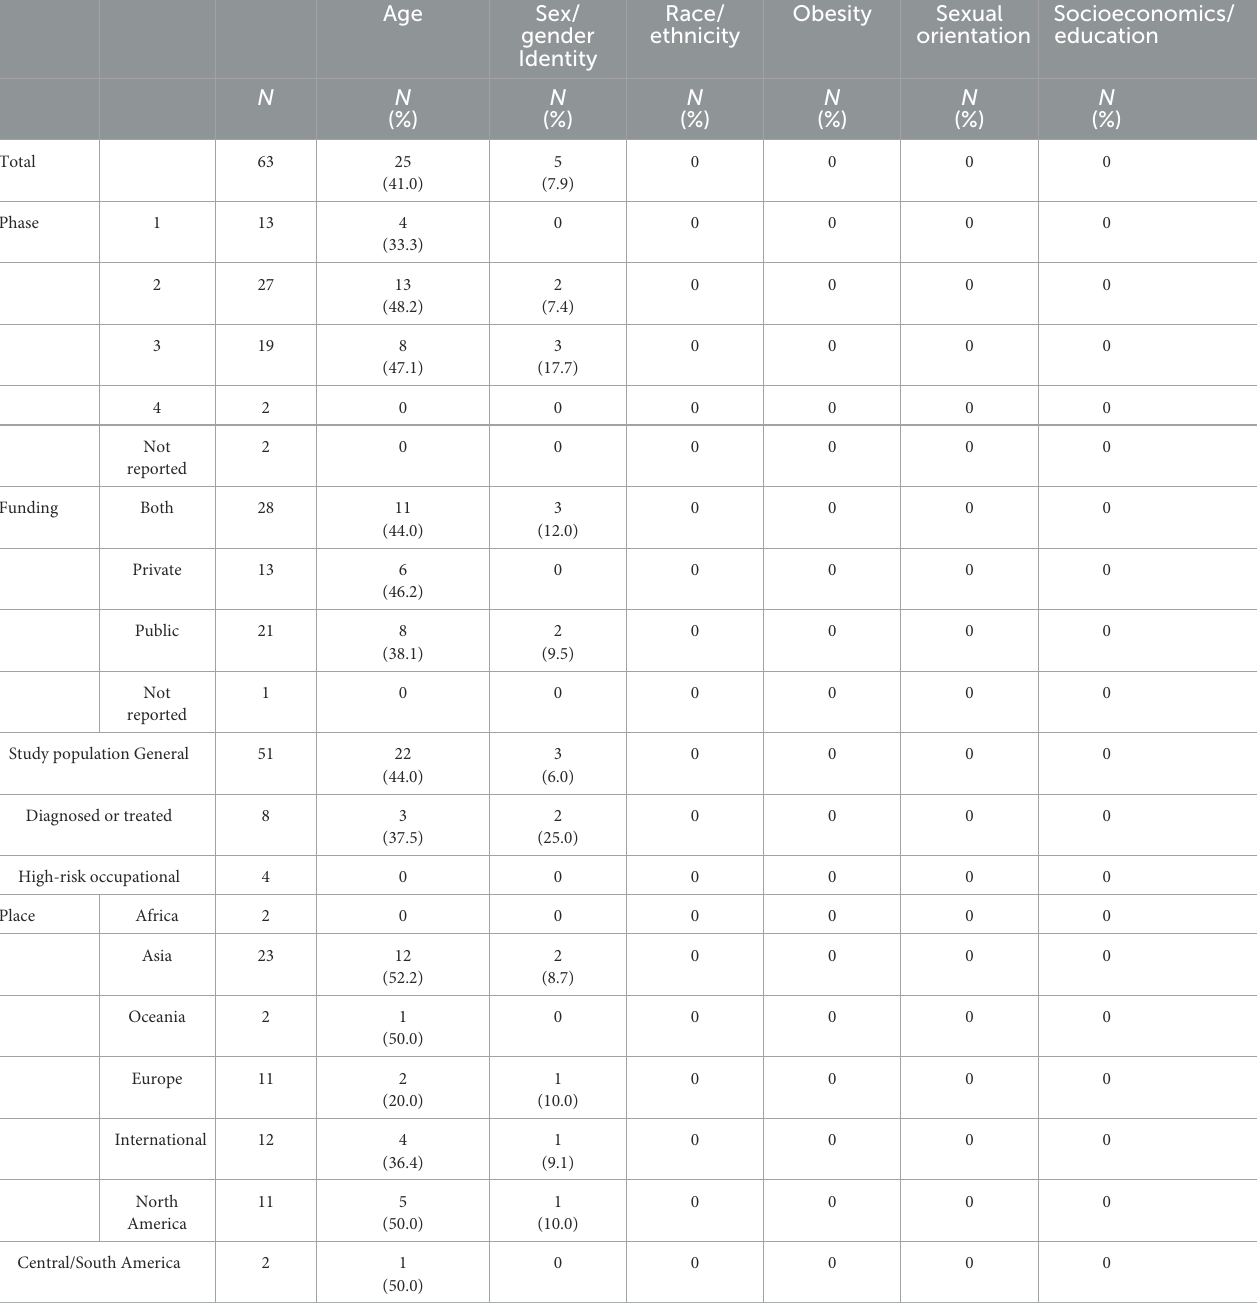
TABLE 4 Report of safety results stratified by axes of social inequity according to study